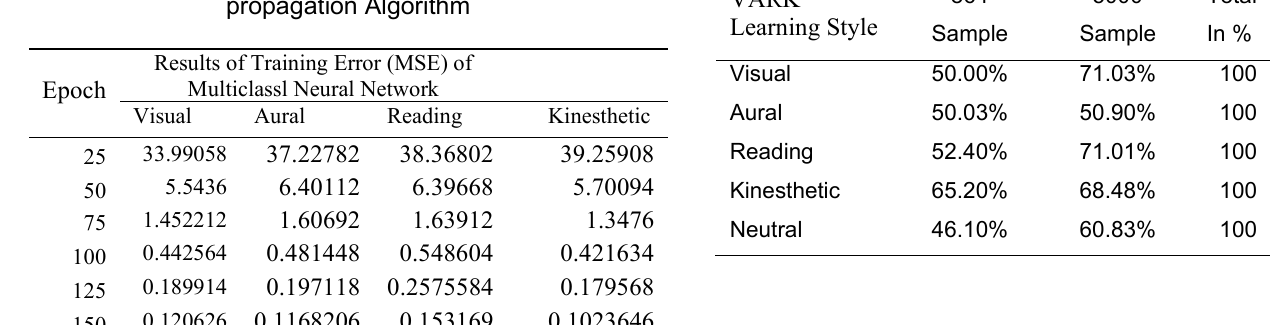
Table 2. Results of Training MCNN with Back propagation Algorithm